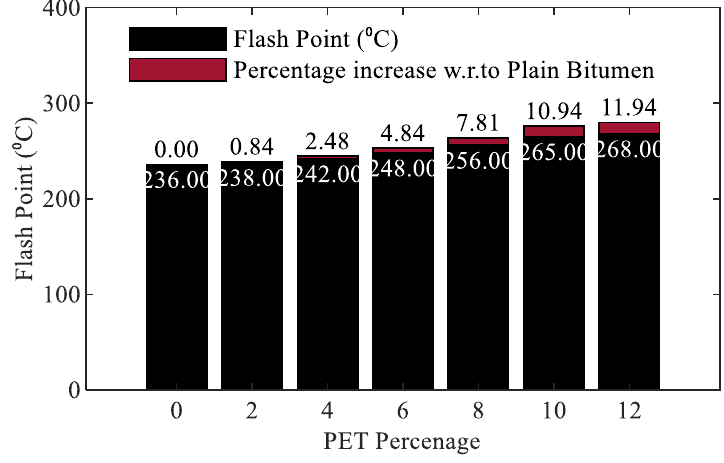
Fig. 21 Variation of flash point with PET content